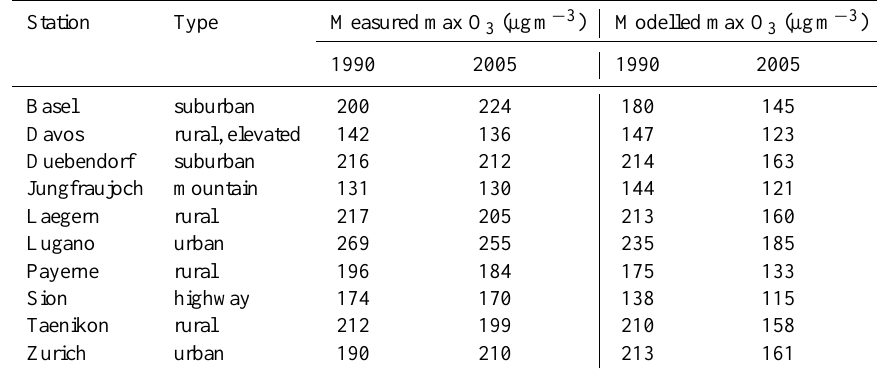
Figure 9. (a) Changes in annual average ozone mixing ratios (ppb) over the European domain, BL 2020–2005 (upper panel), MTFR 2020– 2005 (lower panel). (b) Changes in annual average ozone mixing ratios (ppb) over the Swiss domain, BL 2020–2005 (upper panel), MTFR 2020–2005 (lower panel). Table 4. Measured and modelled peak ozone concentrations at NABEL stations in 1990 and